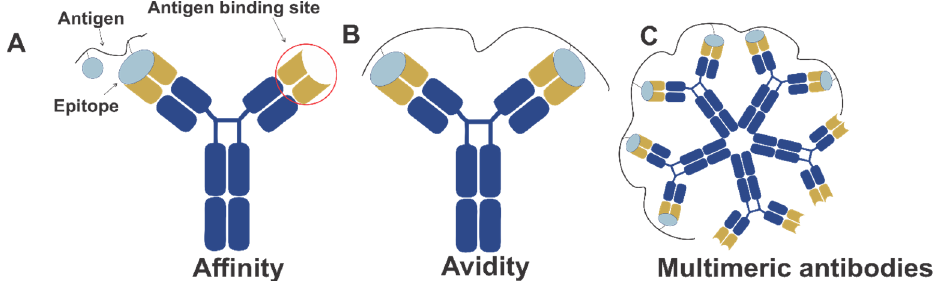
Figure 1. Antibody interaction. ( A ) Affinity in single ligand interaction. Antigen interaction at single antigen binding site (dark yellow variable domain) demonstrating a monovalent interaction. ( B ) Avidity is the sum of the ligand binding interactions. Antigen interacting at 2 antigen binding sites of an antibody, demonstrating a bivalent interaction. ( C ) Multimeric antibodies (such as IgM) increase the avidity of antibodies. CorelDRAW 2020 (Cascade Parent Limited, Ottawa, Canada), CoralDraw ® Graphics Suite, Coral Corperation was used to design the image.